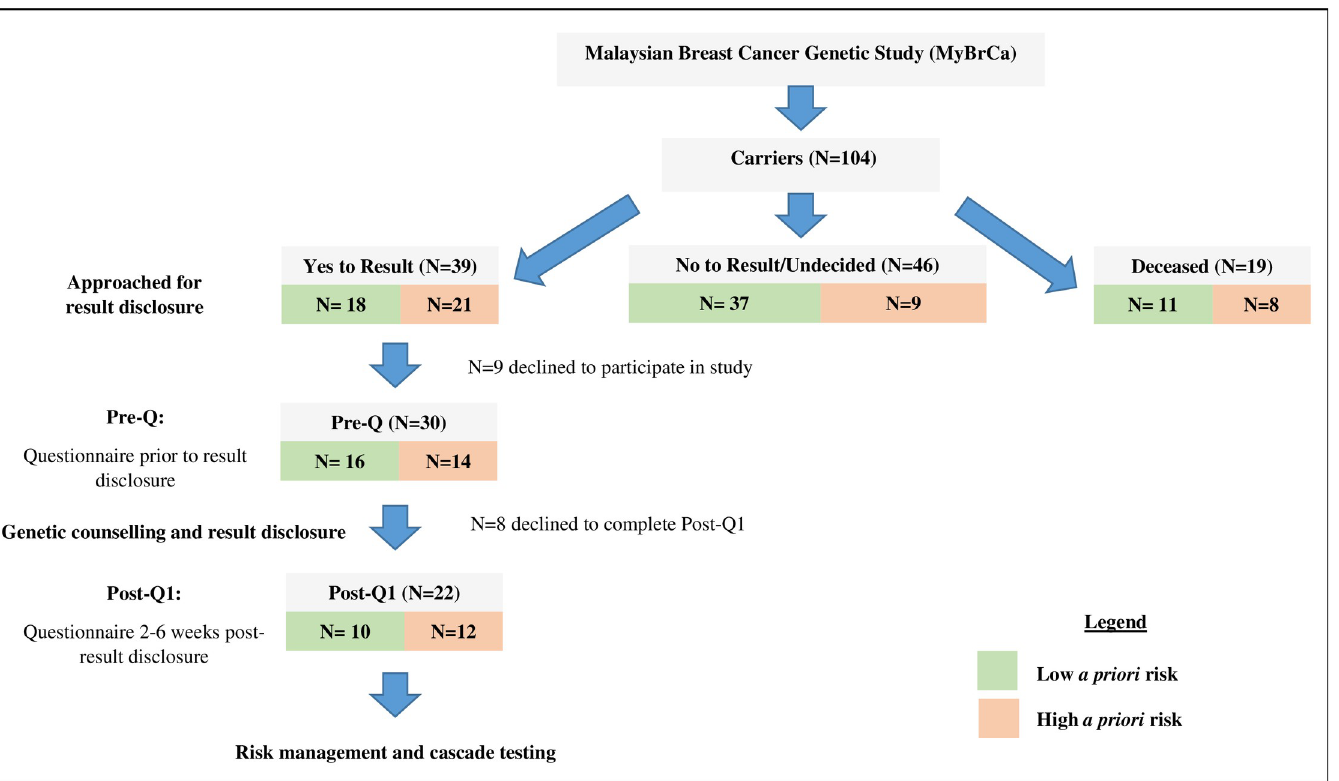
Fig 1. Study flow chart. Abbreviations: N, Number of participants.